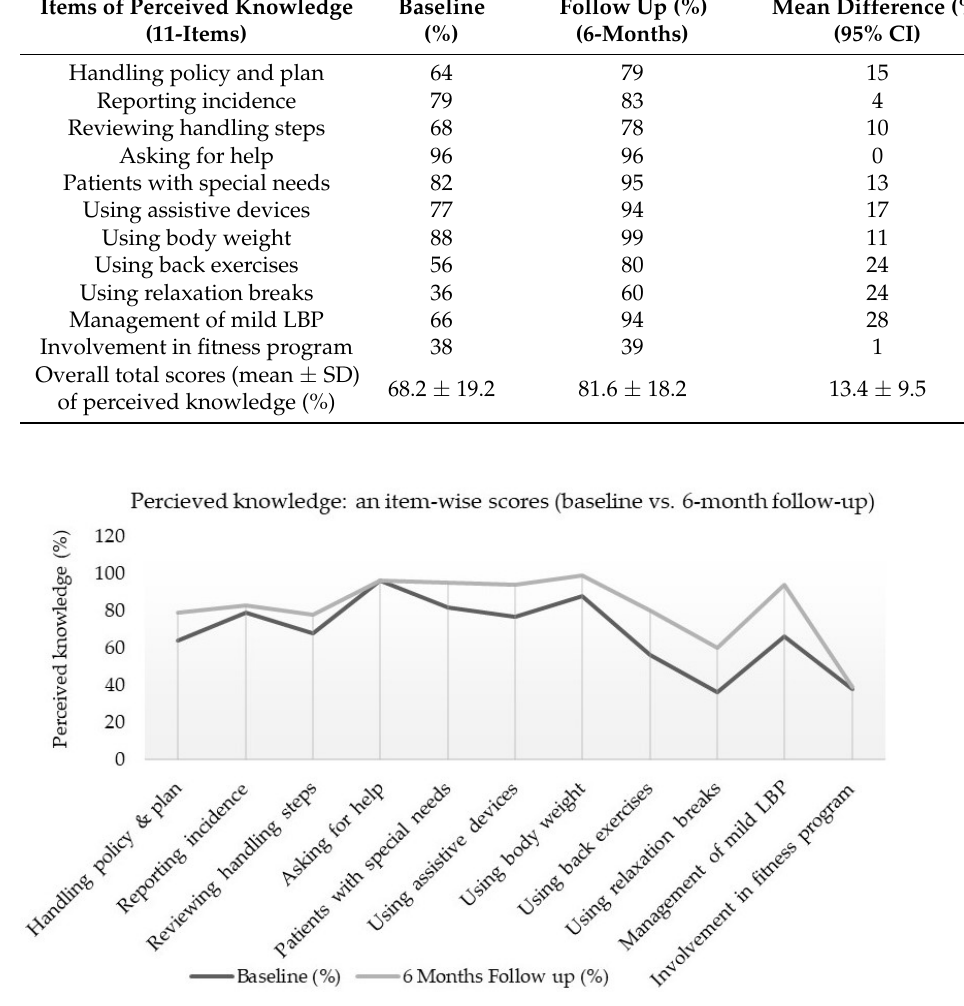
Figure 1. Item-wise comparison of perceived knowledge scores between baseline and 6-month